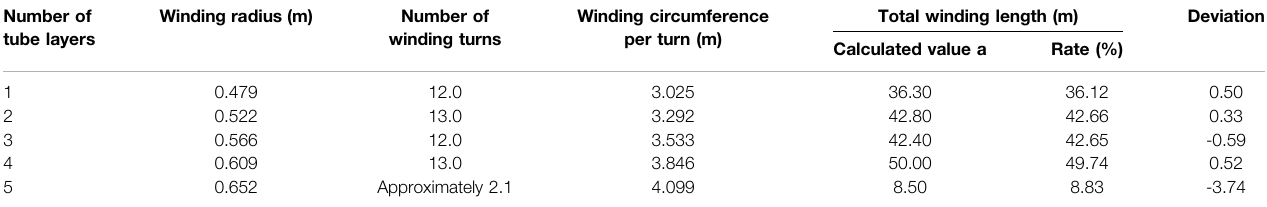
TABLE 2 | Reel and tube parameters. Number of tube layers